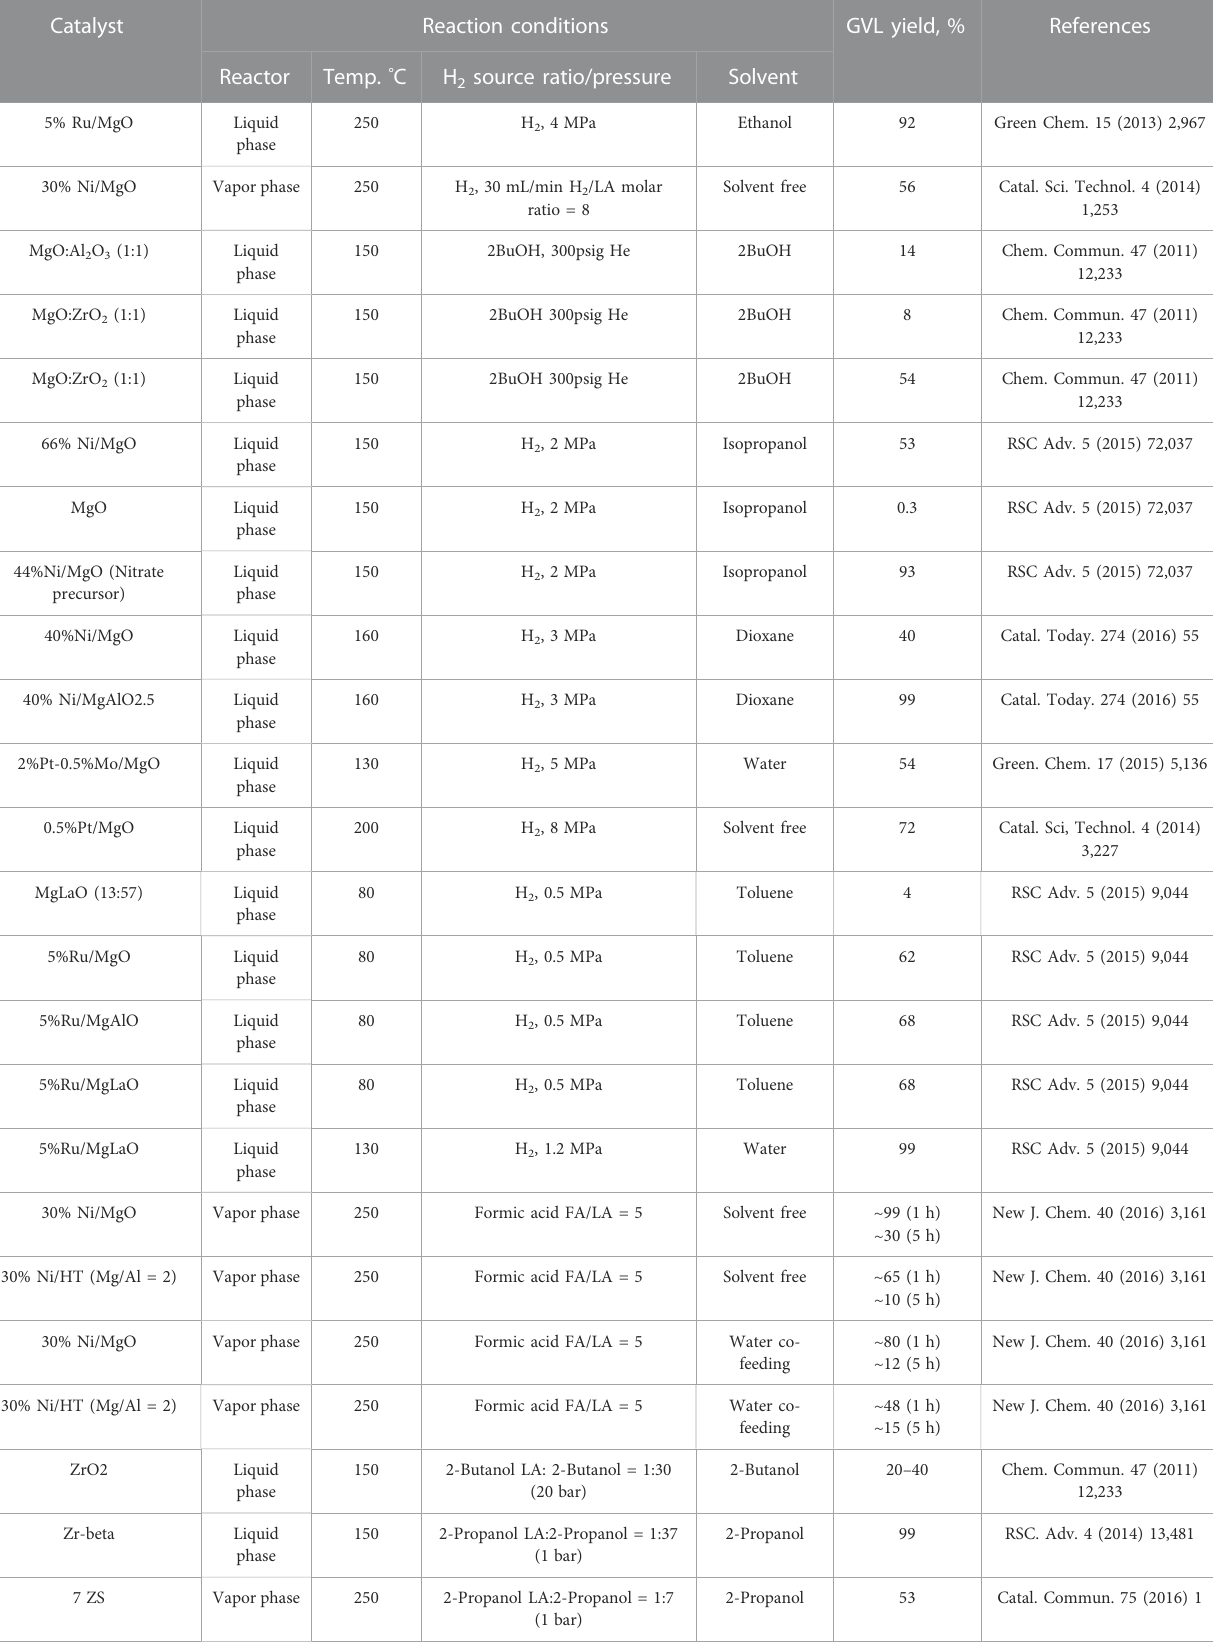
TABLE 5 A comparison of present and literature reported results on conversion of LA to GVL.